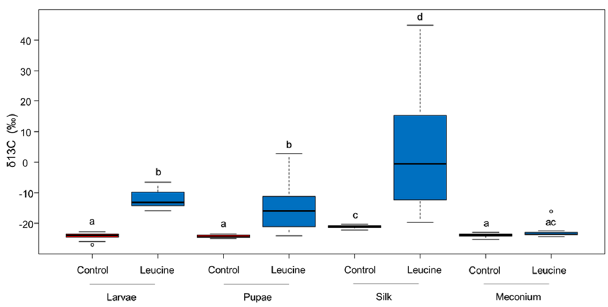
Fig. 2 Allocation of 13C-leucine into brood tissues. δ 13 C values ( ‰ ) in larvae ( N = 42), pupae ( N = 21), silk ( N = 19), and meconium ( N = 29) from colonies fed with 13 C-leucine-enriched arti fi cial nectar (in blue), and their controls (in red). A higher delta indicates higher 13 C levels. The boxes represent the fi rst and third quartiles and the median. The whiskers represent the maximum and minimum values. The circles represent the outliers. A generalized linear mixed model followed by post-hoc pairwise comparisons (Tukey adjusted) was used for statistical analysis. Different letters indicate a pairwise-comparison with P < 0.05.